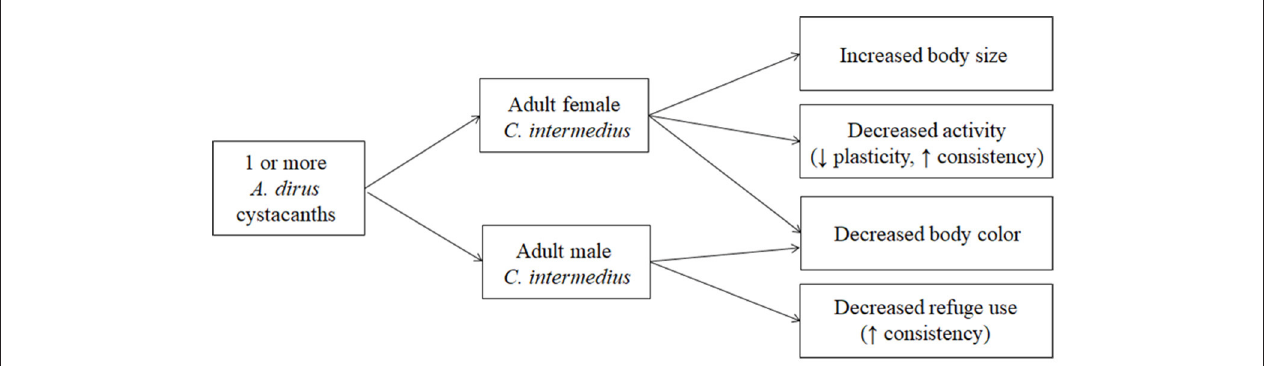
FIGURE 4 | Summary of results obtained for multidimensional modification in C. intermedius . Patterns of modification differed between the sexes but were not affected by variation in parasite intensity. A decrease in body color was the only trait modified in both sexes. Measures of plasticity and individual consistency were obtained for activity and refuge use in two situations (field site,